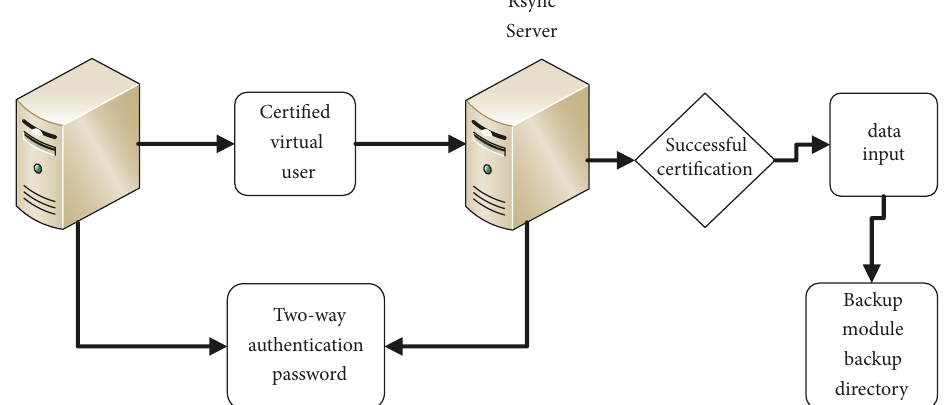
Figure 5: Rsync authentication